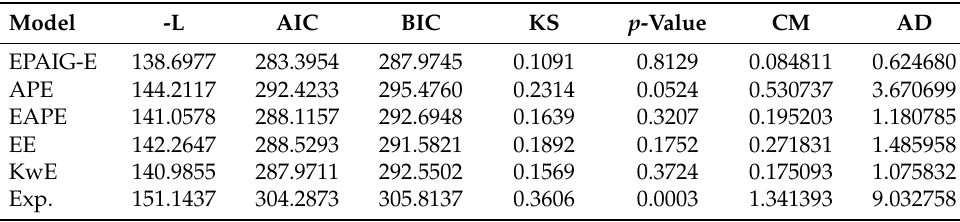
Table 3. The measures -L, AIC, BIC, KS, p -Value, CM, and AD for runoff